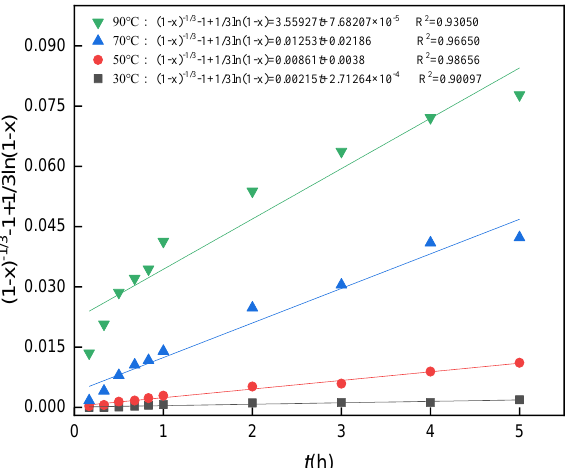
Figure 15. Relationships between 1 − (1 − x) 1/3 and time of aluminum ions.